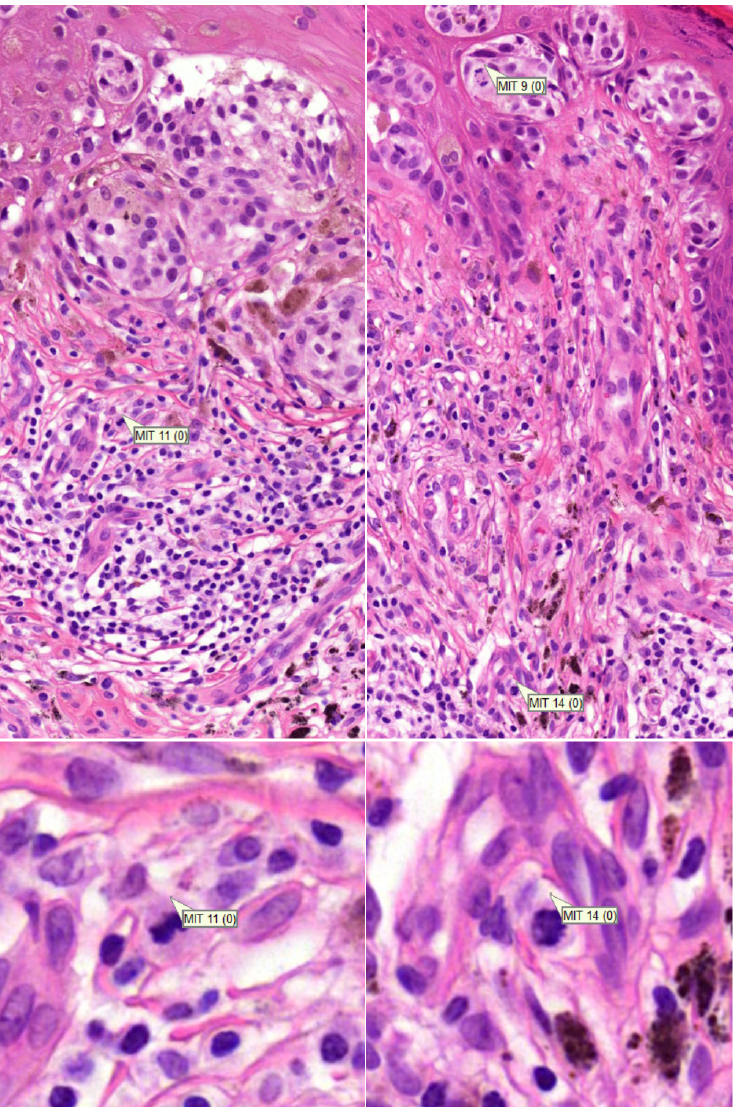
Figure 3. (row above ×200, row below ×800 magnification). Examples of incorrectly attributed mitoses from inflammatory cells located outside of the tumour front.